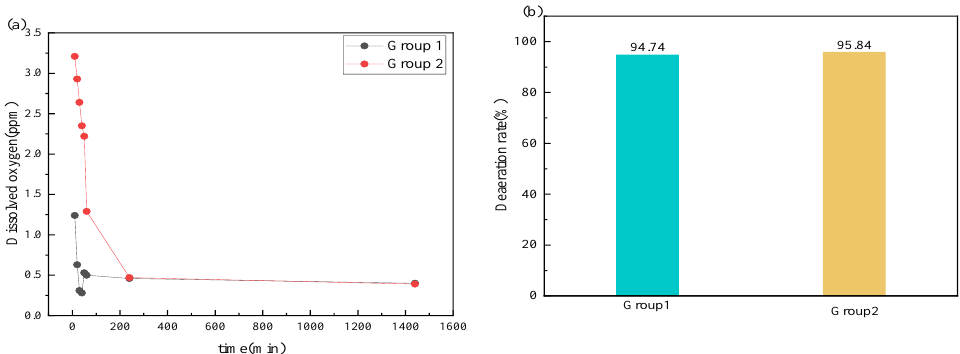
Figure 9. Deoxidation effects in groups one and two. ( a ) dissolved oxygen; ( b ) deaeration rate. Corrosion Inhibition Rate Experiment